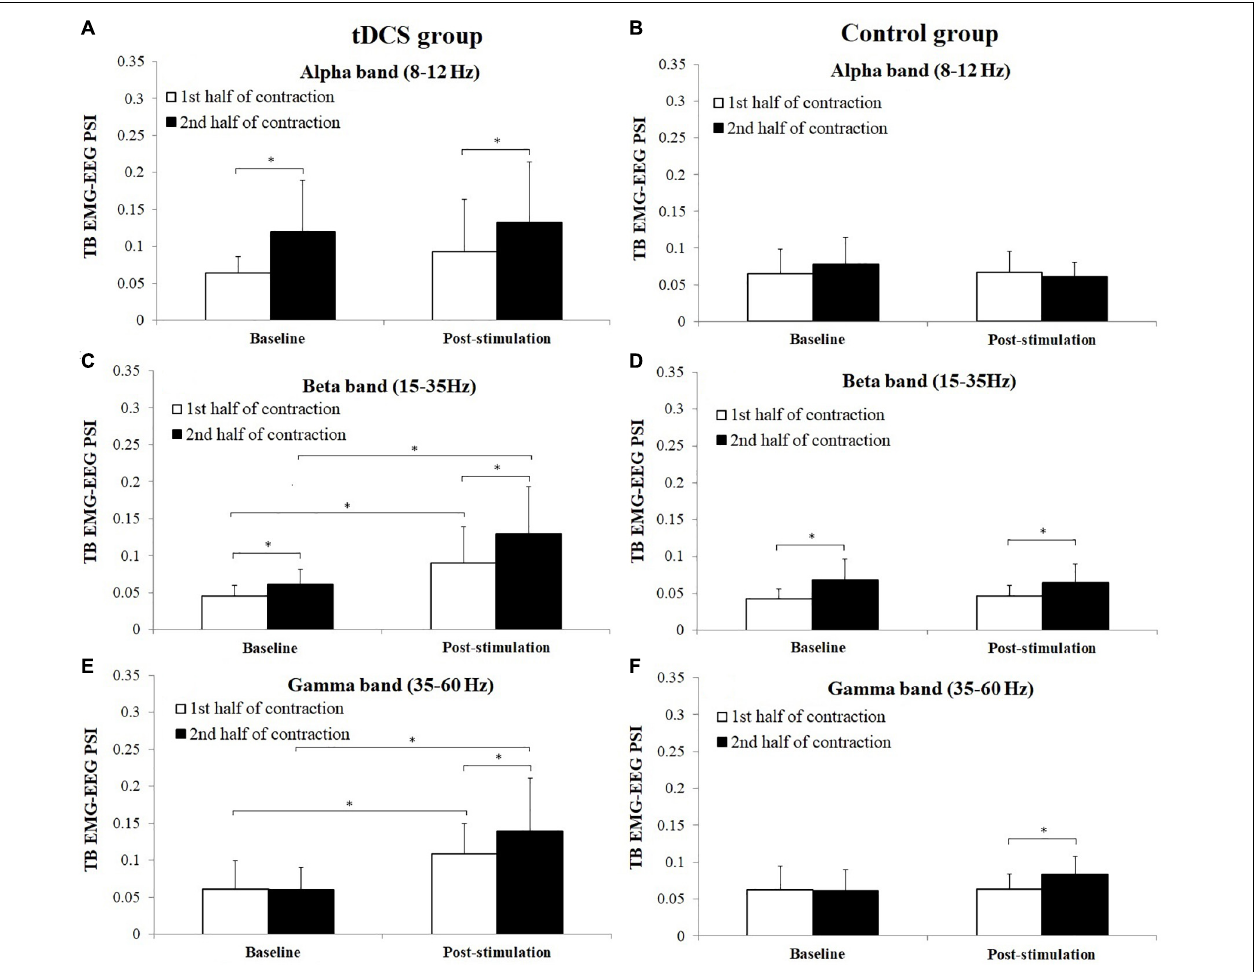
FIGURE 8 | Comparisons of triceps brachii (TB) electromyography (EMG)–electroencephalogram (EEG) phase synchronization index (PSI) (mean ± SD) in alpha, beta, and gamma frequency bands between the 1st and 2nd half of contraction for baseline and post-stimulation test in tDCS (A,C,E) and control (B,D,F) group subjects. *demonstrated a significant difference of observed index between the baseline and post-stimulation test or between the 1st and 2nd half of